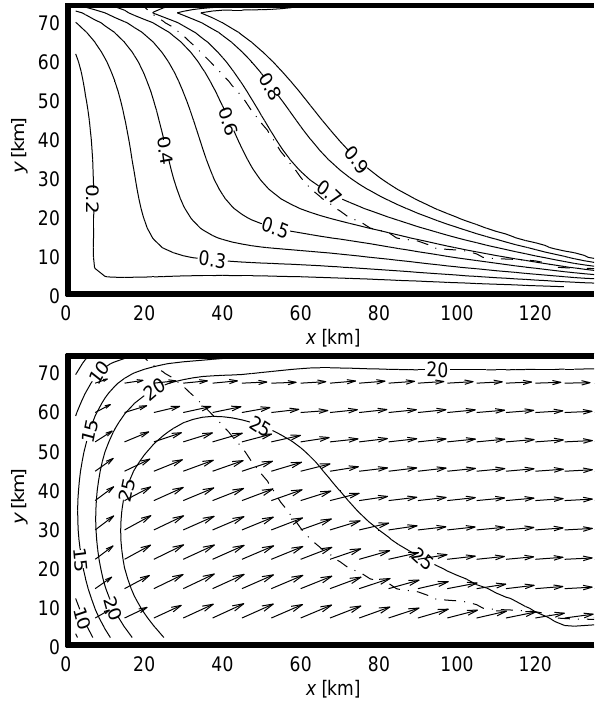
Fig. 8. Sea-ice concentration (top) and speed and velocity (bottom) using Hibler’s original formulation for the elliptic yield curve, after eight days of model integration. Neither figure shows a discernible polynya edge. The dash-dotted line shows the isoline for A =0.8 from the control